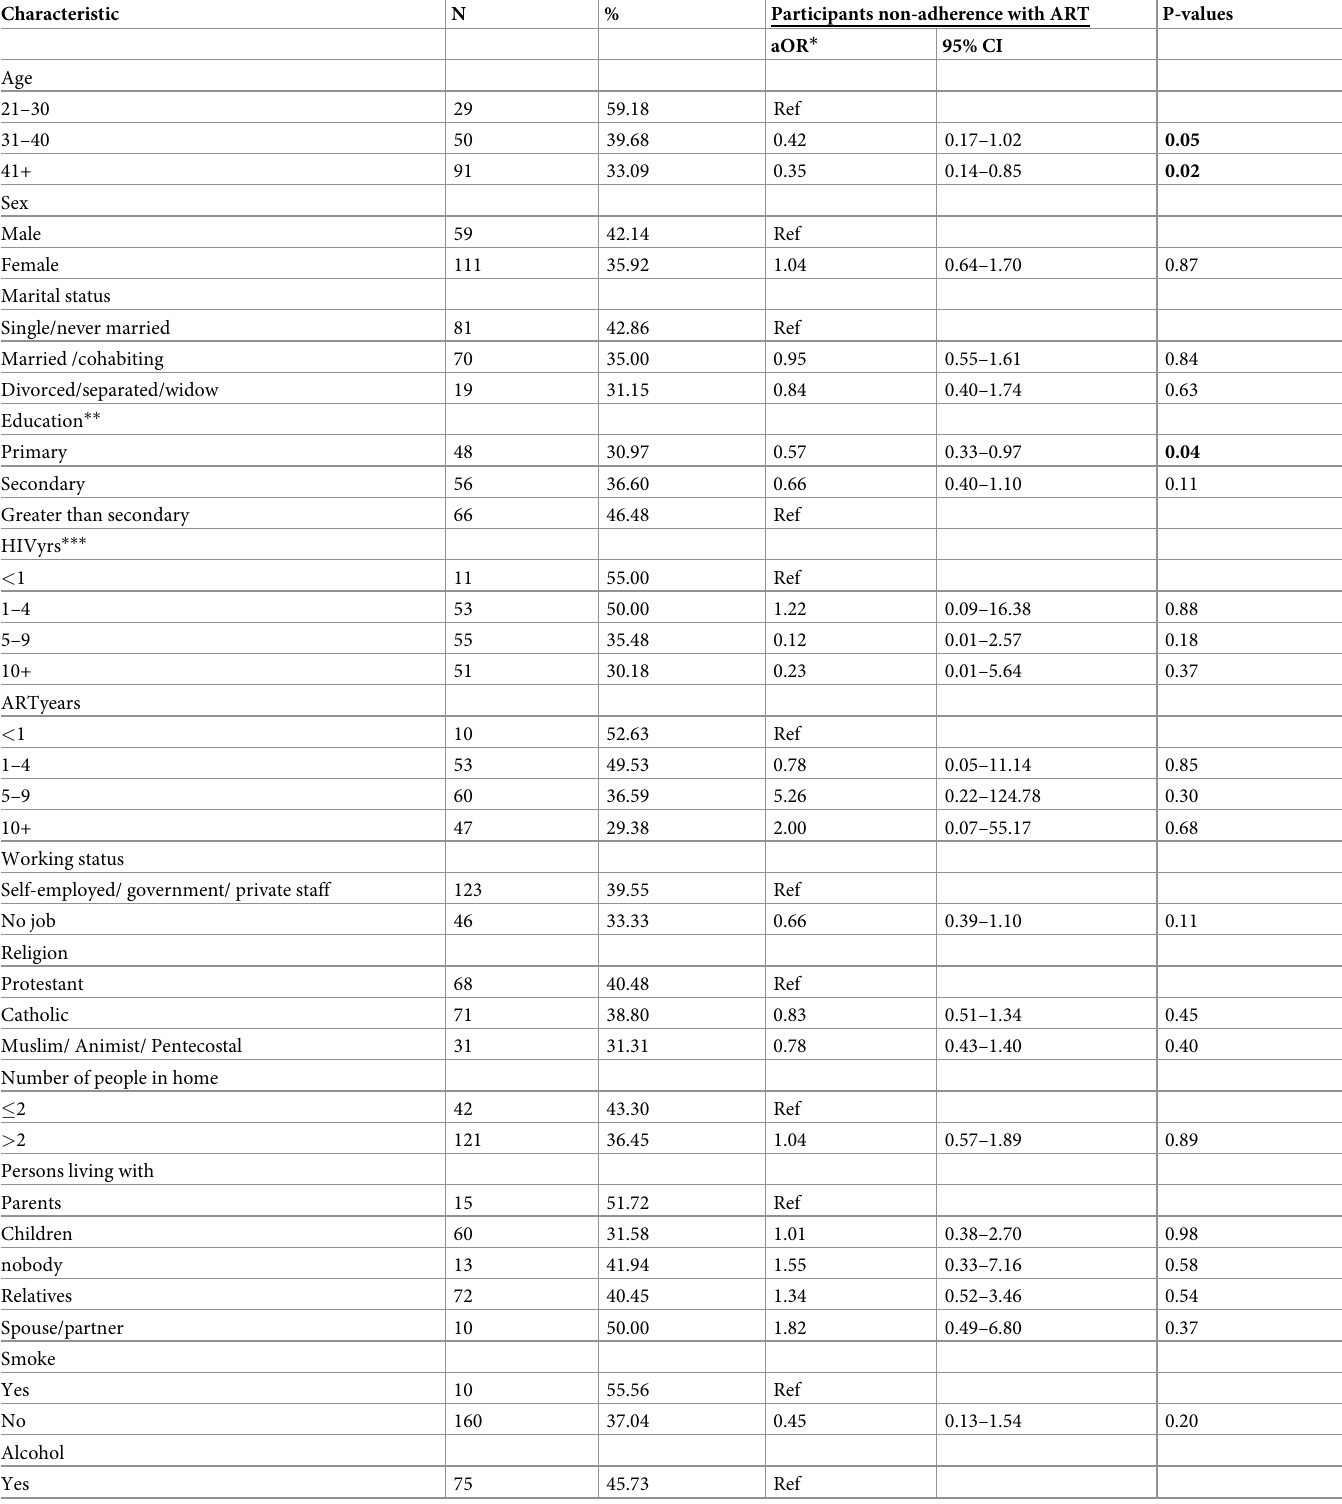
Table 5. Correlates of participants non-adherence with ART- multivariable